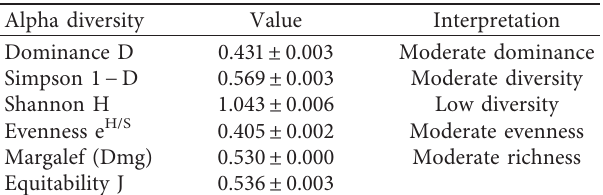
Figure 4: Lorenz curve of evenness of the OTUs. Table 2: Alpha diversity of the phyla in A. nigrocincta gut cal- culated using